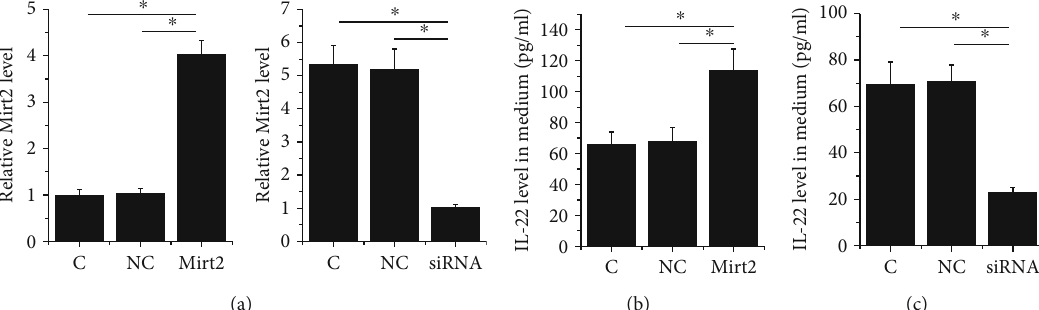
Figure 3: Mirt2 positively regulated IL-22 in HCnEpCs. Mirt2 expression vector or siRNA was transfected into HCnEpCs (treated with LPS as mentioned above). The expression level of Mirt2 was signi fi cantly altered in HCnEpCs with Mirt2 expression vector or siRNA transfection at 24 h after transfections comparing C and NC (a). Moreover, Mirt2 overexpression led to increased (b), while Mirt2 siRNA silencing led to decreased secretion of IL-22 from HCnEpCs in medium (c) ( ∗ p < 0 : 05 ).